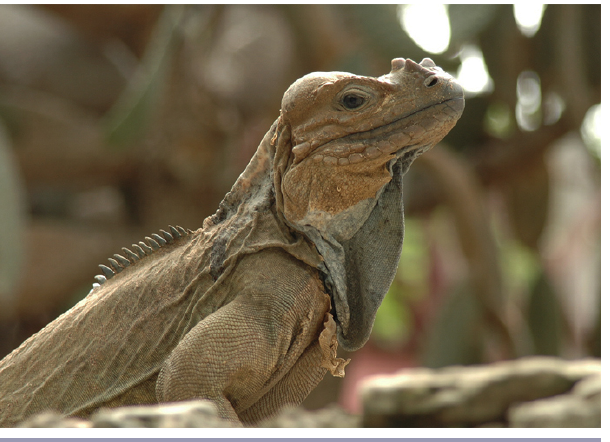
Fig. 6 . Rhinoceros iguana ( Cyclura cornuta ) in captive breeding compound. (© Puntacana Ecological Foundation)